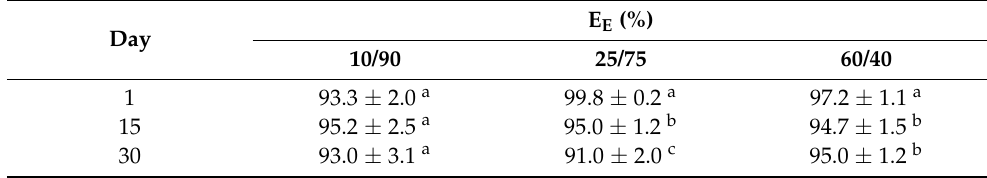
Table 6. Complex modulus at 0.2 Hz (G* 0.2 ) as a function of time (1, 15 and 30 days) obtained for W 1 /O/W 2 multiple emulsions at three different O/W ratios for the secondary emulsion (10/90, 25/75 and 40/60). Different superscript letters within a column indicate significant differences ( p < 0.05).